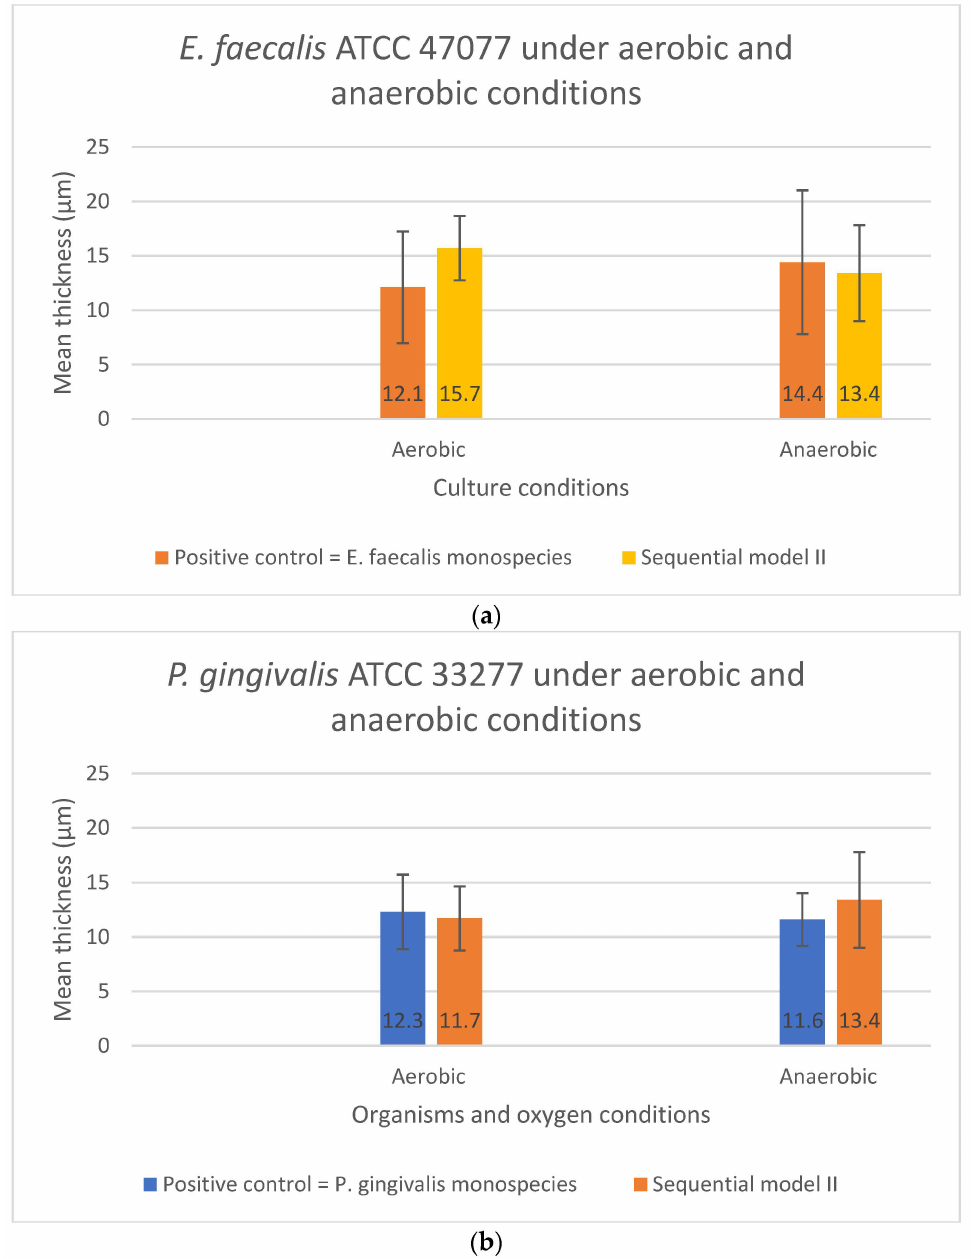
Figure 5. The biofilm thickness of ( a ) E. faecalis and ( b ) P. gingivalis cultured independently under aerobic and anaerobic conditions based on the Sequential model II and mono-culture models. Data represent the mean and standard